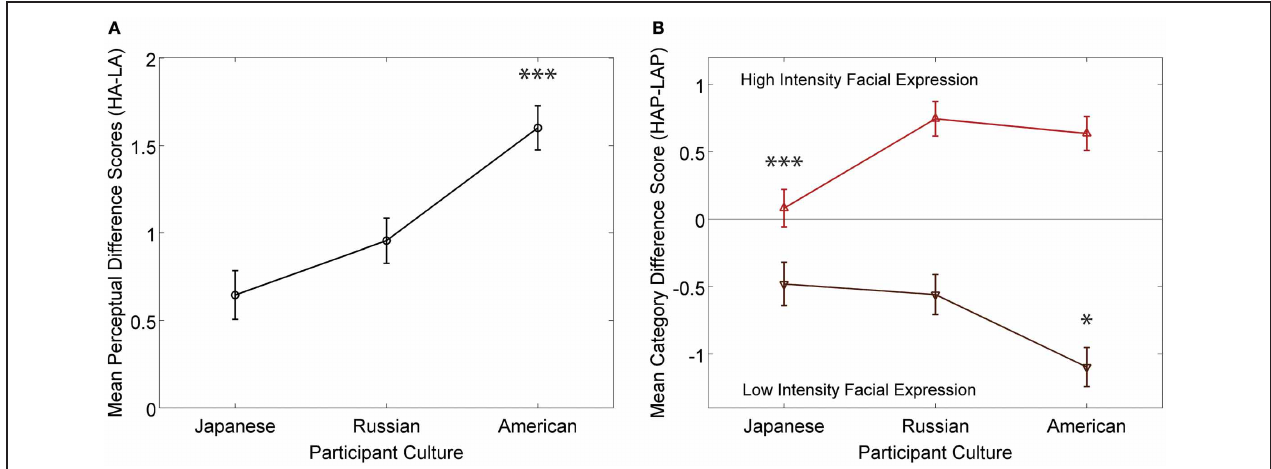
FIGURE 1 | Summary of main results from Pogosyan and Engelmann (2011). Results show cultural differences in the underlying cognitive mechanisms involved in emotion intensity perception. (A) Cultural differences in distinguishing between high and low intensity expressions of affect were observed, such that American participants differentiated between intensity to a greater degree than other cultures. (B) Cultural